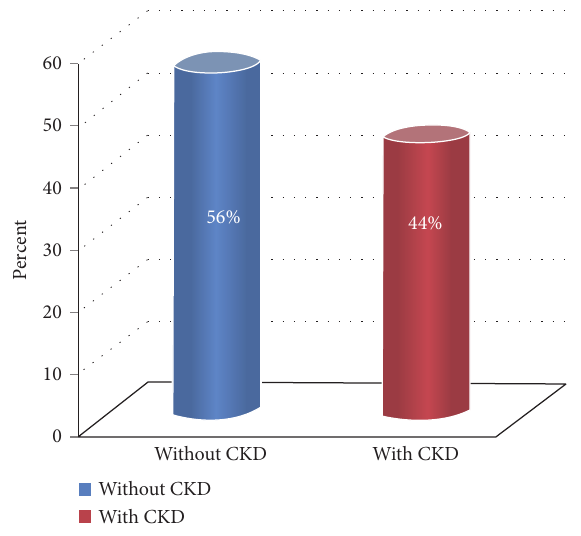
Figure 2: Graphic representation of CKD.